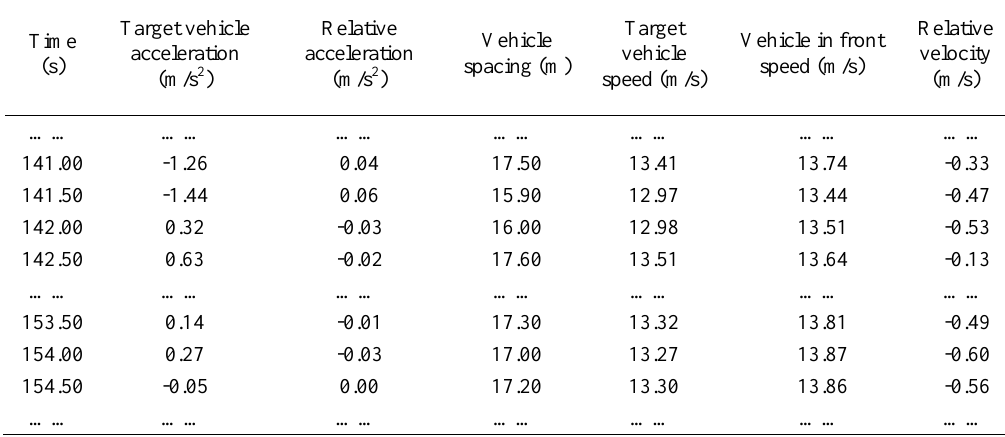
Table 6. Risk-based driver part of the experimental